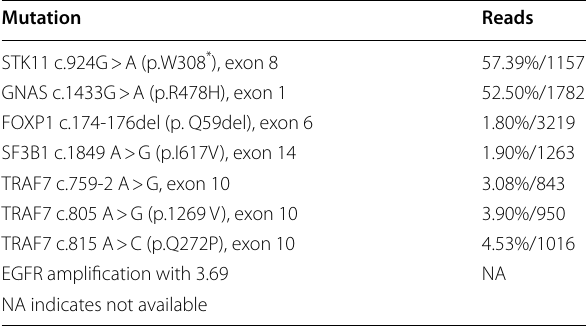
Table 1 Results of NGS in the patient Mutation